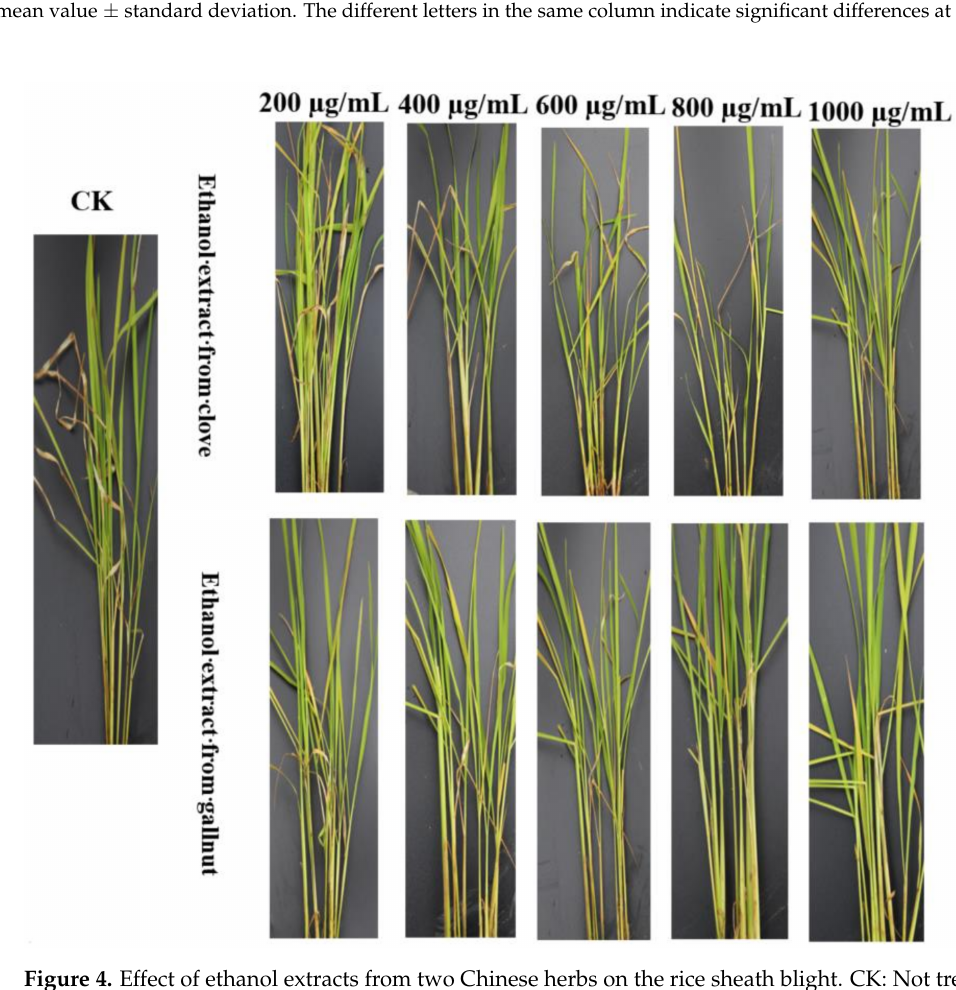
Figure 4. Effect of ethanol extracts from two Chinese herbs on the rice sheath blight. CK: Not treated with drug; The ethanol extracts of gallnut and clove were of different concentrations: 200 µ g/mL, 400 µ g/mL, 600 µ g/mL, 800 µ g/mL, 800 µ g/mL, 1000 µ